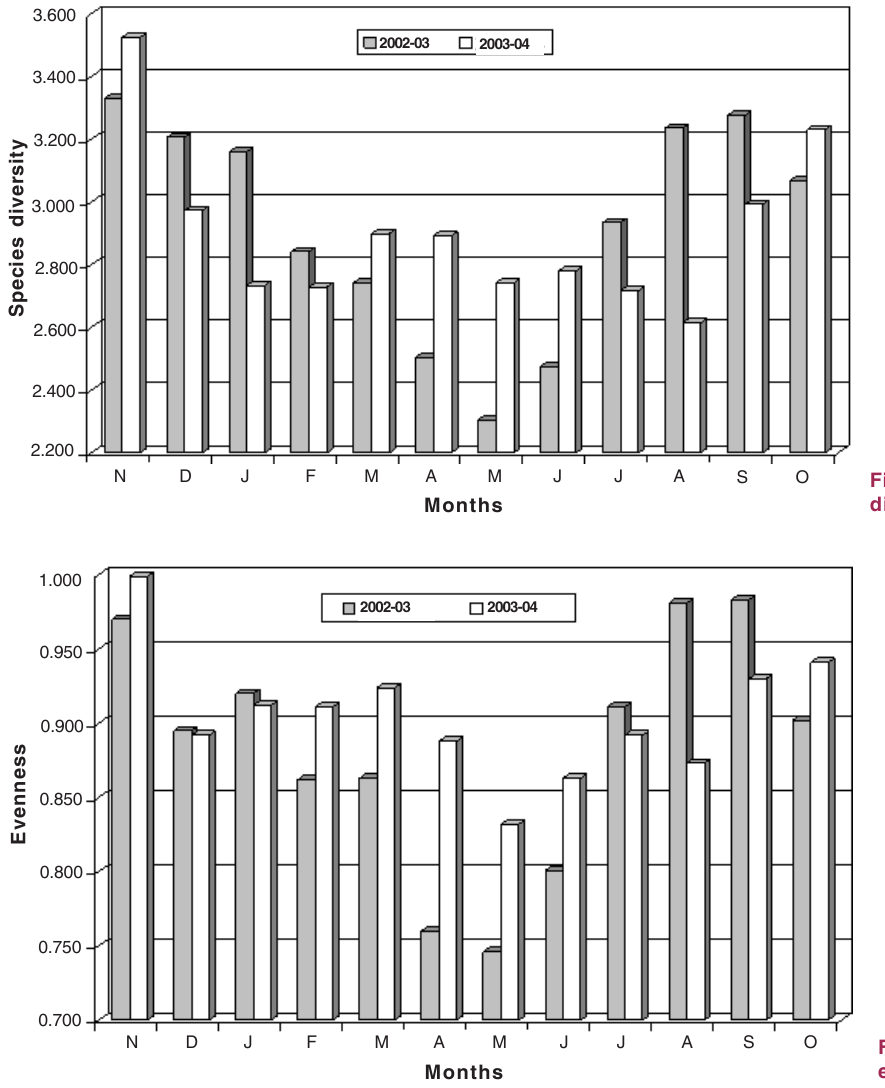
Figure 7. Monthly variations in evenness of